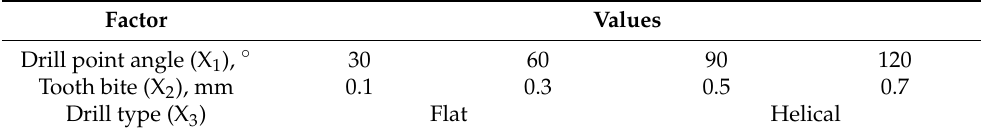
Table 1. The values of analyzed input factors. Factor Values Drill point angle (X 1 ),